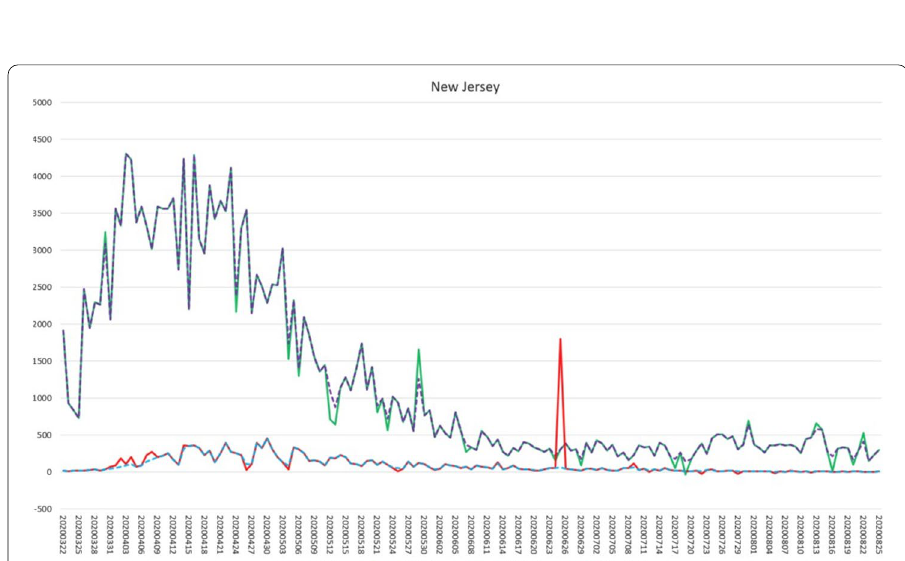
Fig. 8 Smoothing filter—State level. The chart illustrates the filter operating at a higher level (the state of New Jersey). Note that statewide the Deaths adjustment at 06/25 indicates nearly 1800 one day deaths compared to an average of around 50. This is effectively filtered out along with several anomalously high and low